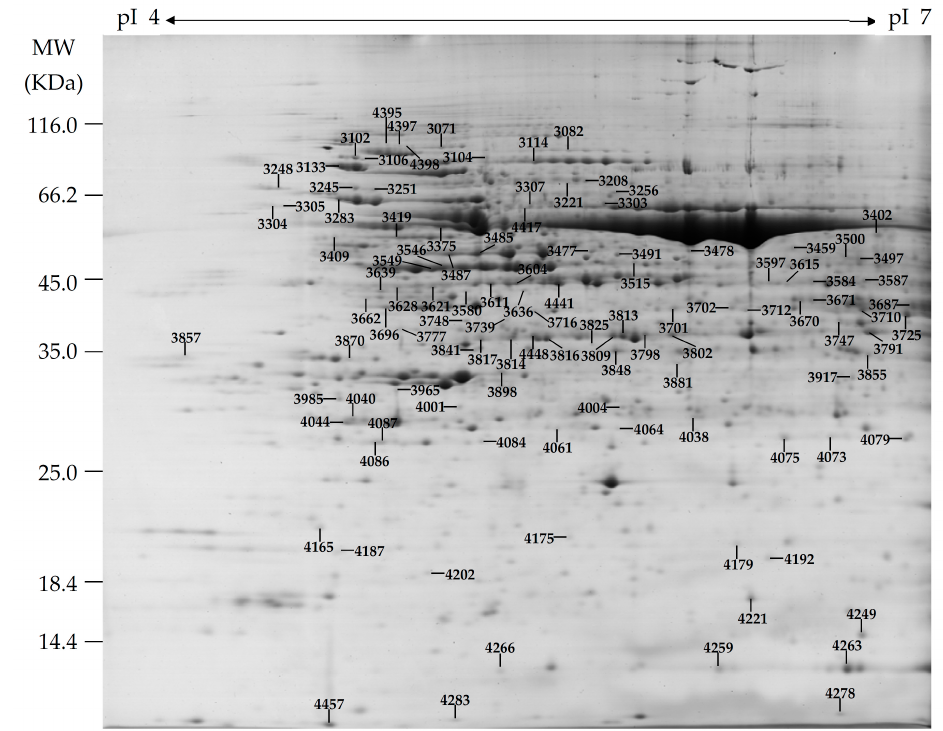
Figure 5. A representative 2DE gel images of proteins from leaves of Populus simonii × Populus nigra . Proteins were separated on 24 cm linear gradient immobilized pH gradient (IPG) strips (pH 4–7) using isoelectric focusing (IEF) in the first dimension, followed by 12.5% sodium dodecyl sulfate polyacrylamide gel electrophoresis (SDS-PAGE) gels in the second dimension. The 2DE gel was stained with Coomassie Brilliant Blue. Molecular weight (MW) in kilodaltons (KDa) and isoelectric point (pI) of proteins are indicated on the left and top of the gel, respectively. Eighty-one H 2 O 2 -responsive proteins identified by matrix-assisted laser desorption/ ionization (MALDI) tandem time of flight (TOF-TOF) mass spectrometry were marked with numbers on the gel, and the detailed information can be found in Table 1, Figure S1, and Tables S1.